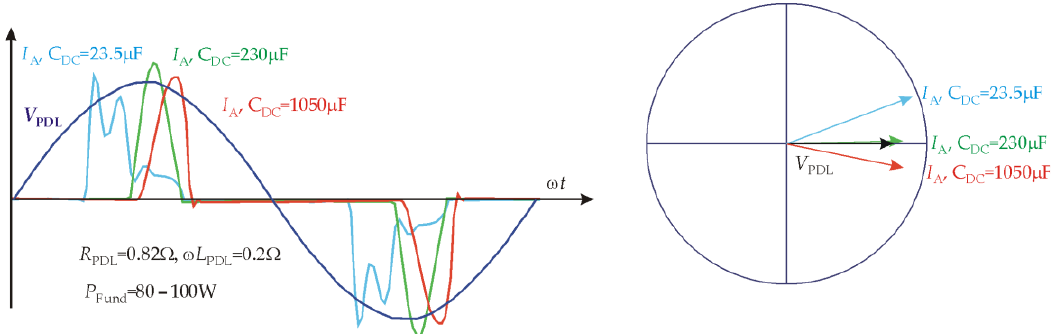
Figure 11. Time and phase diagrams of the current at the point of connection of single-phase diode rectifier supply-side device to the PDL in the case of different DC capacitance value.